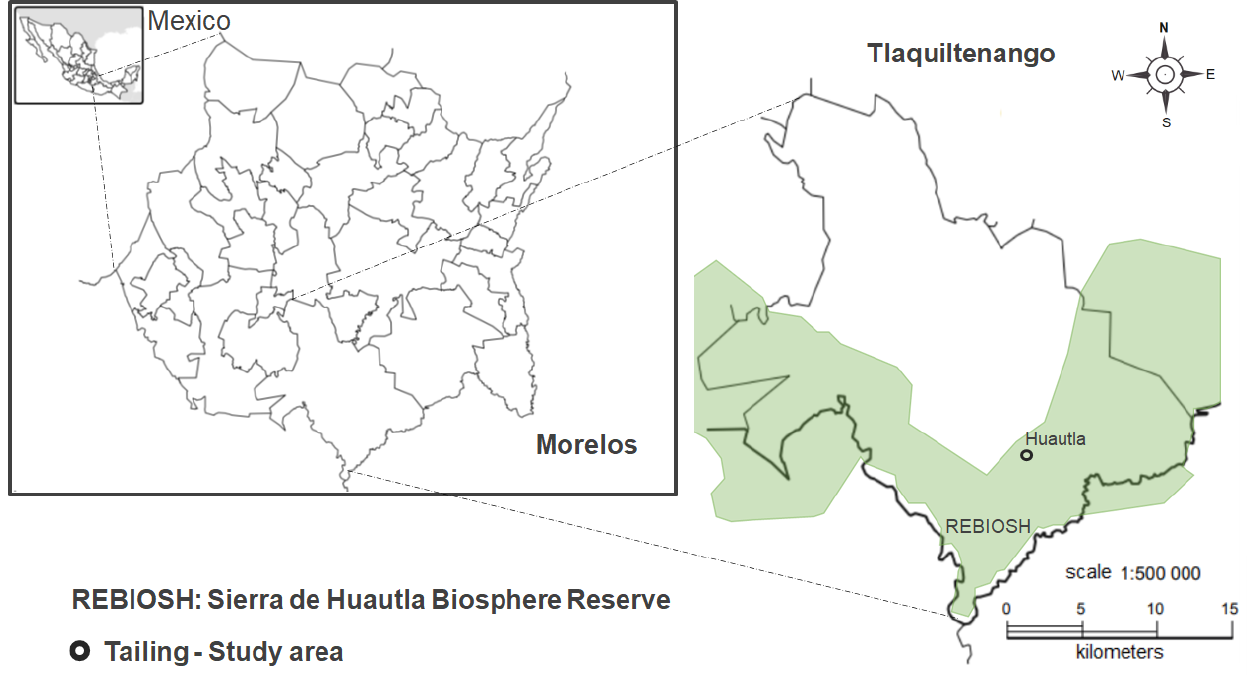
Figure 4. Geographical distribution of the study site at the Sierra de Huautla Biosphere Reserve, Morelos, Mexico.